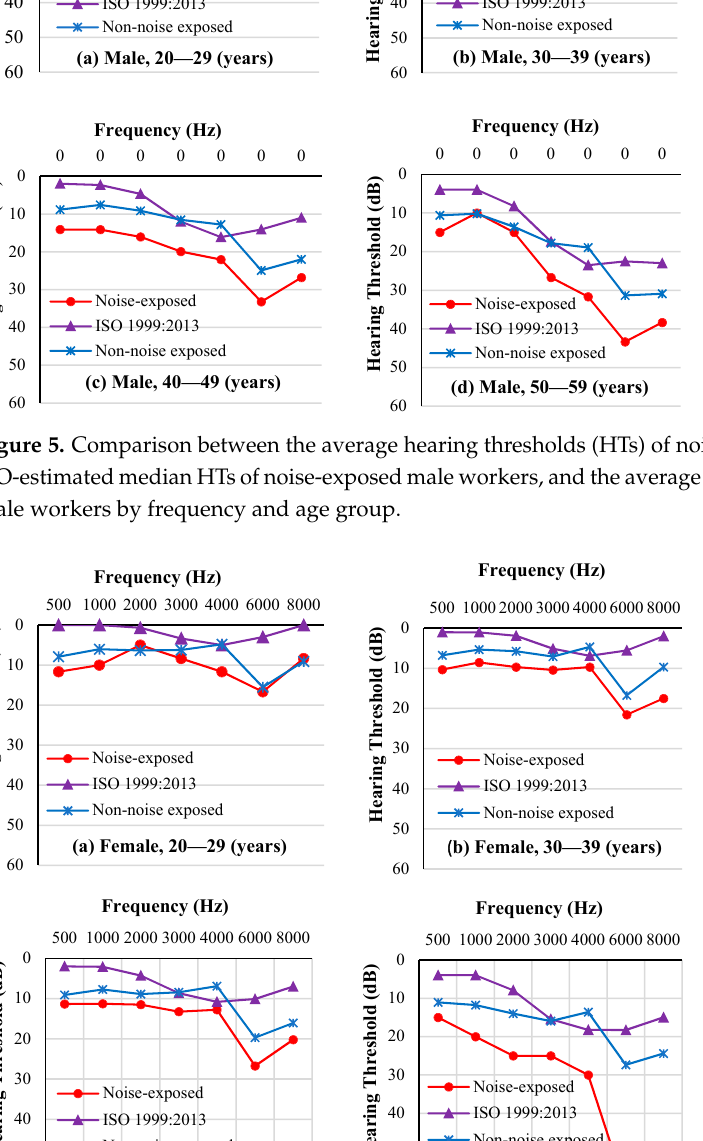
Figure 6. Comparison between the average HTs of noise-exposed female workers, ISO-estimated